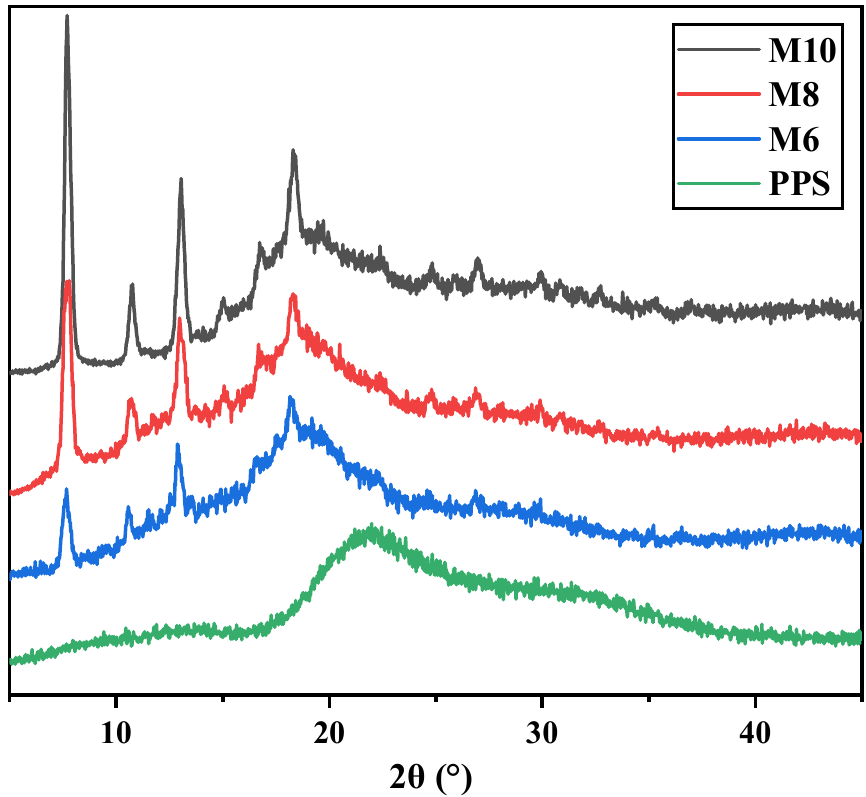
Figure 6. XRD patterns of PPS and ZIF-8/PPS fiber membranes.